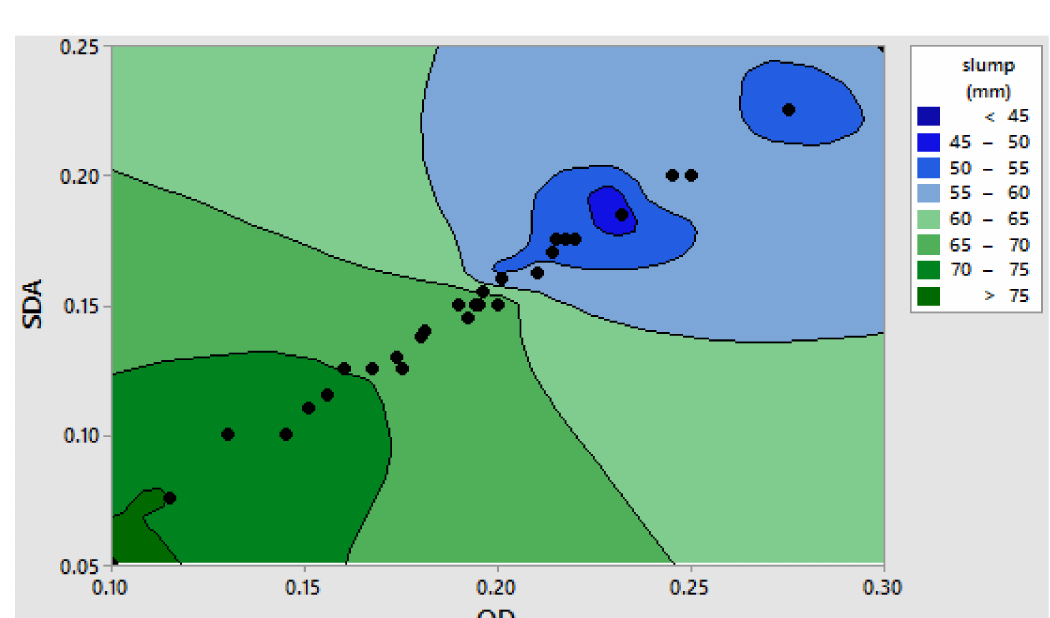
Figure 6. Contour plot of SDA and QD vs. slump response. (The black dots illustrate the regions in the legend where the points for the SDA and the QD factors meet. The response magnitude at those points are shown in the legend in varying color